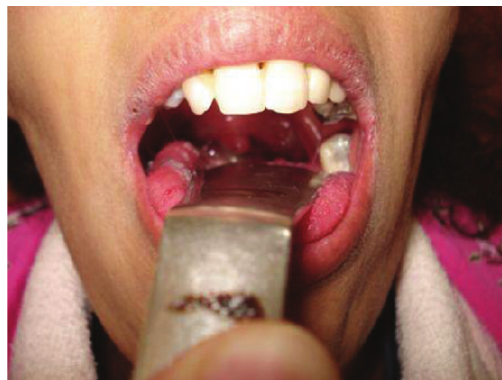
FIGURE 1: Bulging of the posterior wall of the oropharynx.